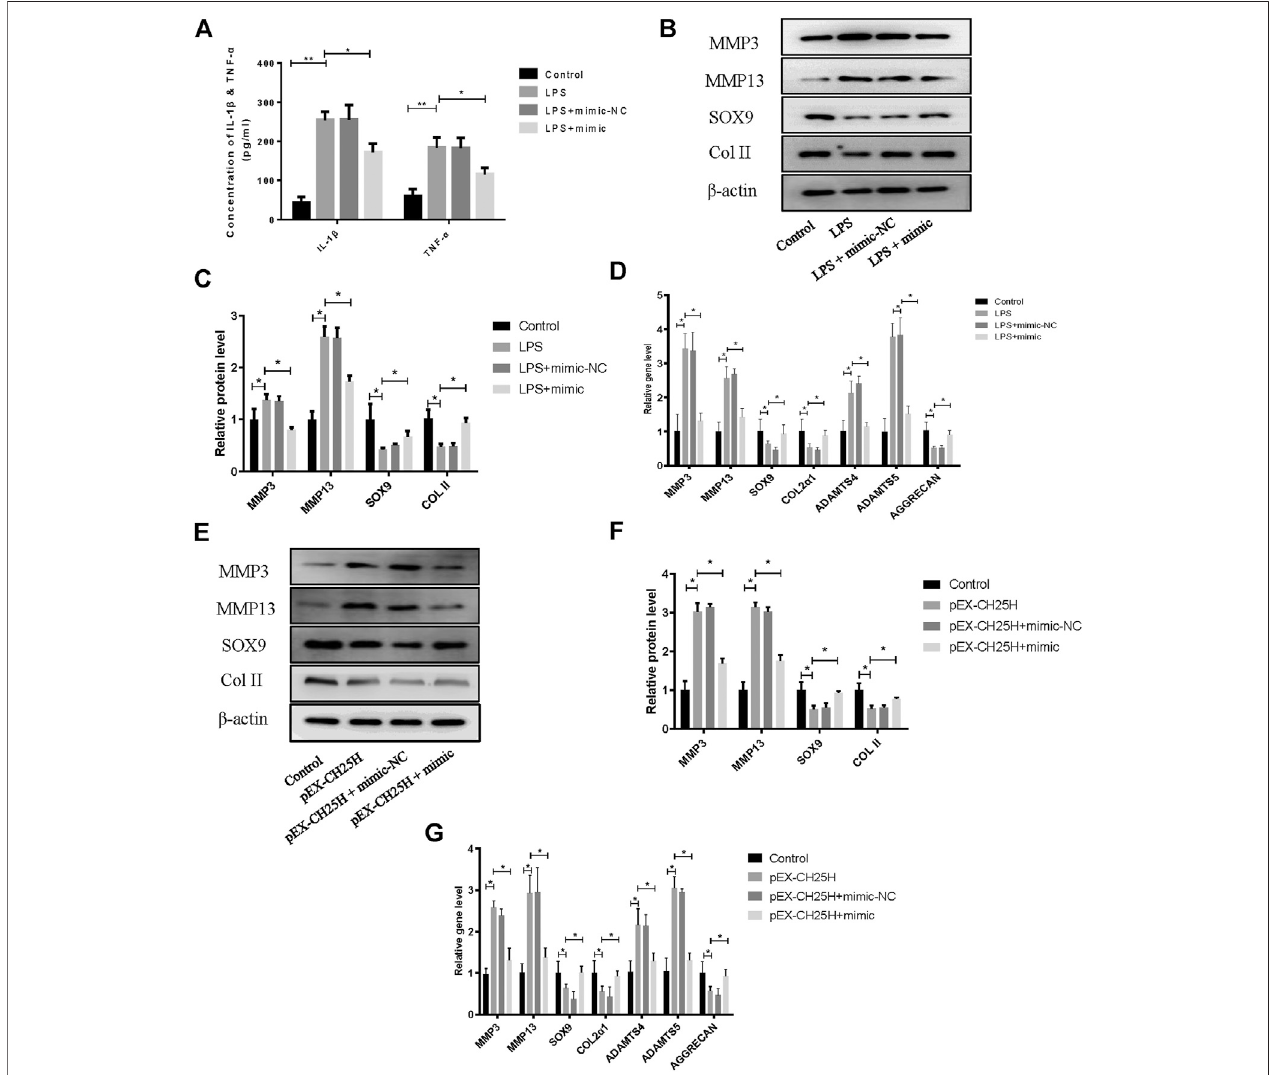
FIGURE 5 | MiR-10a-3p regulates in fl ammation and extracellular matrix homeostasis in chondrocytes. (A) Concentrations of IL-1 β and TNF- α in chondrocytes supernatant were detected by ELISA. (B , C) MMP3, MMP13, SOX9, and Collagen II expression in chondrocytes were analyzed via western blotting. The band intensity was quanti fi ed by normalizing to β -actin ( n (cid:1) 3). (D) MMP3, MMP13, SOX9, COL2 α 1, ADAMTS4, ADAMTS5, and Aggrecan expression in chondrocytes were analyzed via qRT-PCR. (E, F) MMP3, MMP13, SOX9, and Collagen II expression in chondrocytes were analyzed via western blotting. The band intensity was quanti fi ed